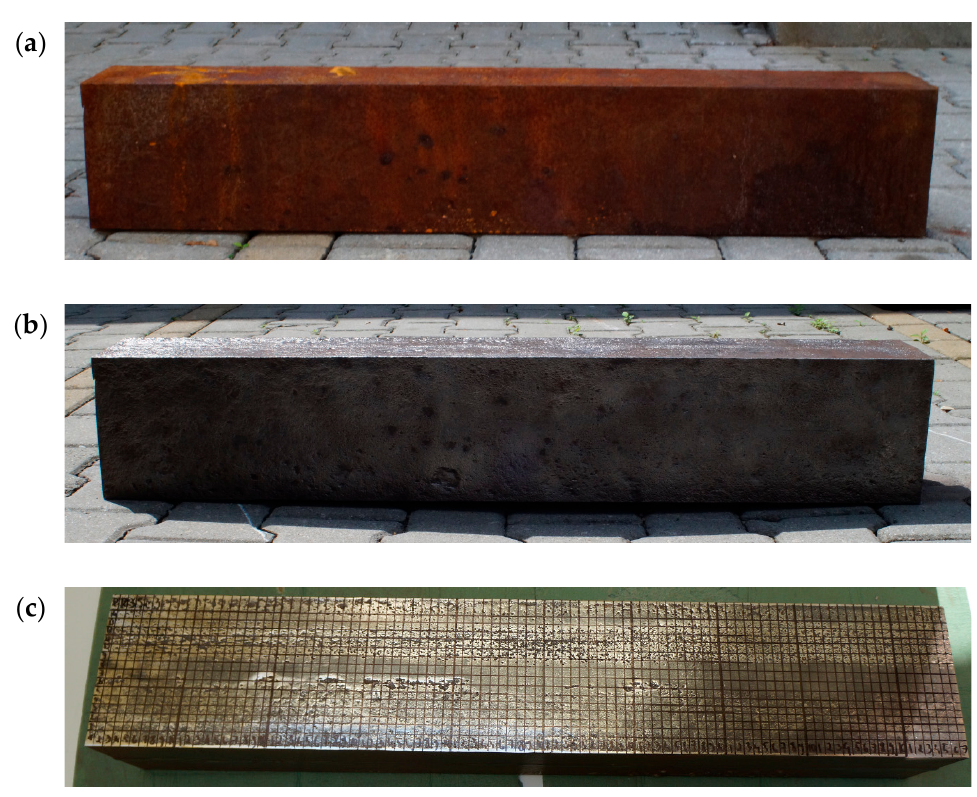
Figure 1. Guide section taken from the shaft steelwork: ( a ) before; ( b ) after cleaning; ( c ) mesh view on web.